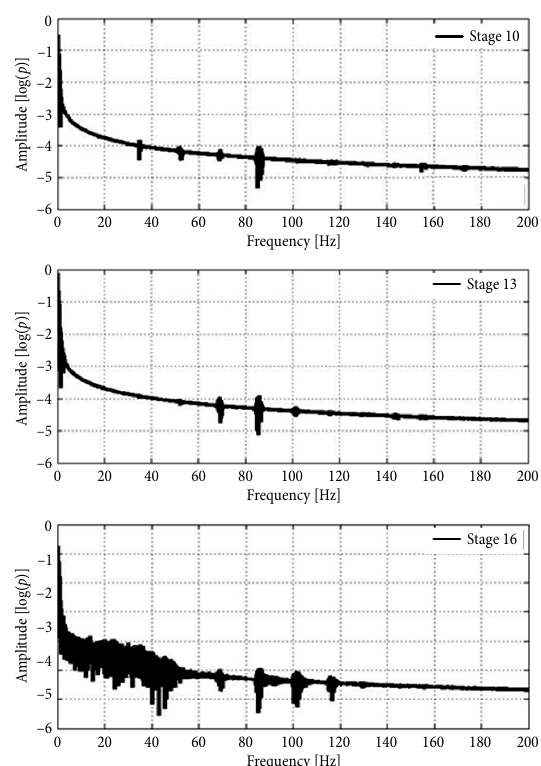
Fig. 10. Dependencies of a variation of flow in the vertical pipe at different depths when load pressure p load varies periodically: a – H = 300 m; b – H = 210 m; c – H = 120 m; d – H = 30 m (when